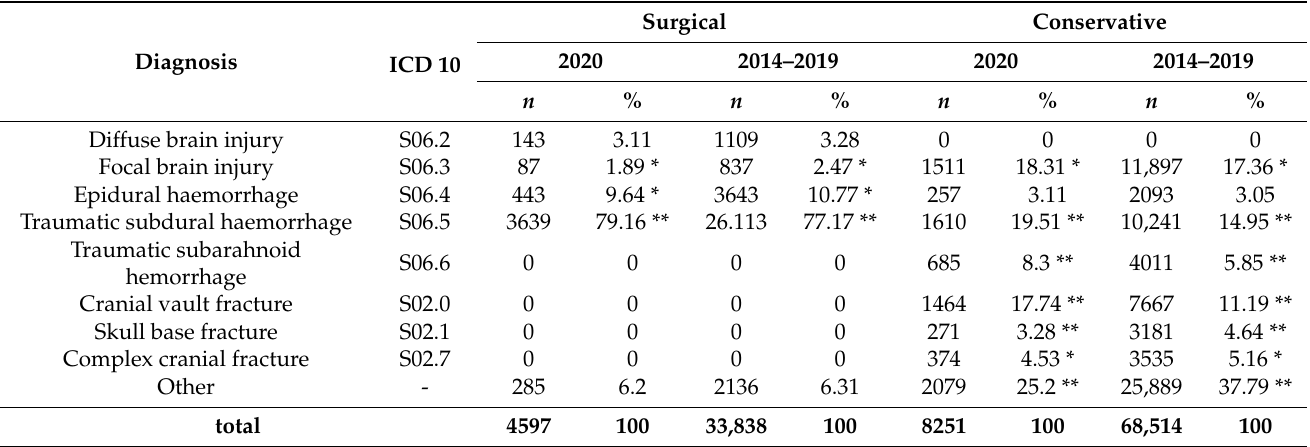
Table 1. Diagnoses of hospitalized patients during the COVID-19 pandemic and preceding years